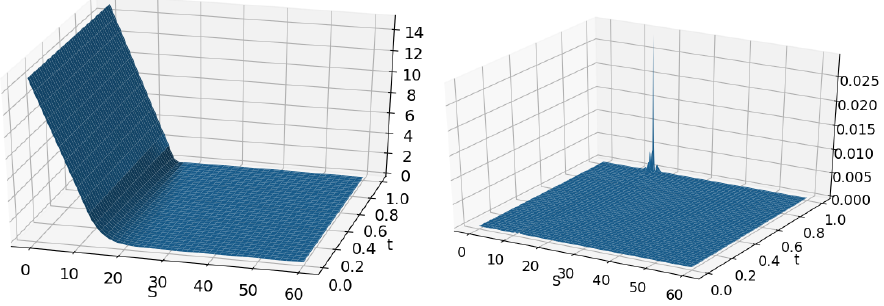
Figure 4. American option price with dividends ( top ). Error surface comparing with the solution obtained by finite element method ( bottom ). Solution obtained by variance normalization method.